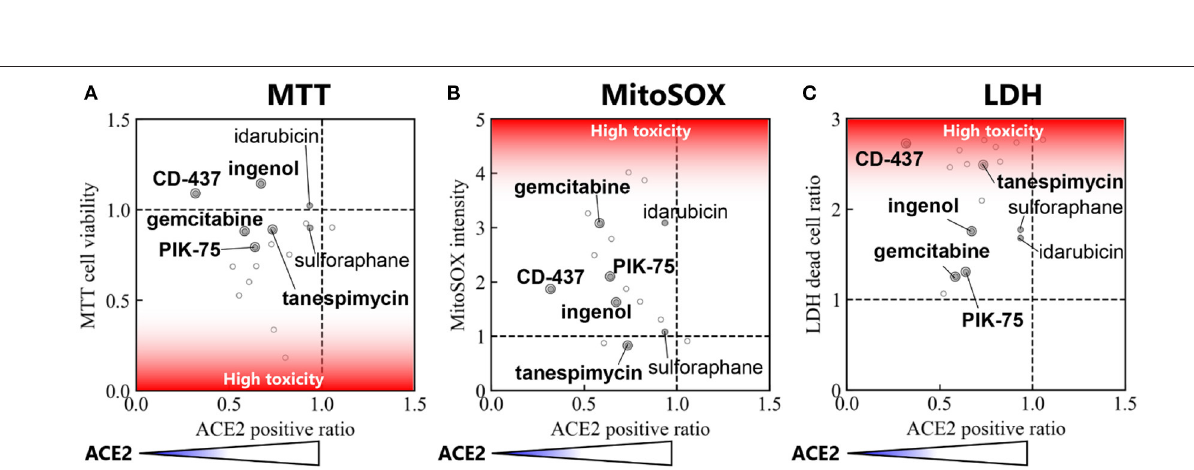
FIGURE 4 | (A) Representative image showing ACE2 staining in BEAS-2B. ACE2-high expressed (ACE2 positive) cells are detected and then ACE2 positive ratio is calculated. (B) Representative cell scoring masks indicating ACE2 expressing cells (Green) and ACE2 negative cells (Red). (C) ACE2 positive ratios in each drug treatment compared to the control ( n = 8 in samples and n = 23 in control). Error bars mean 95% confidence interval. * p < 0.05, ** p < 0.01.